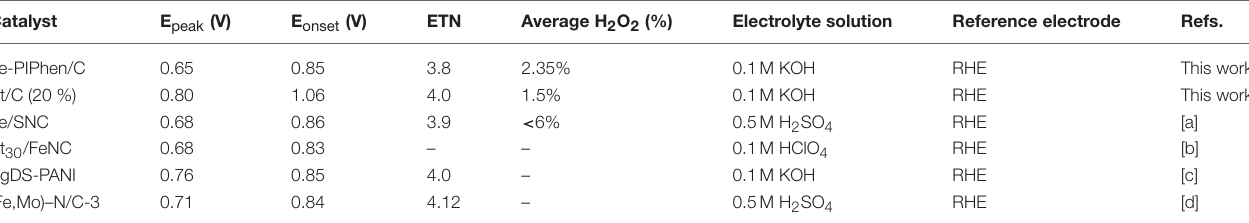
TABLE 2 | The electrocatalytic parameters of non-precious metal catalysts for ORR reported in recent years. Catalyst E peak (V) Average H 2 O 2 (%) Electrolyte solution Reference electrode Refs.